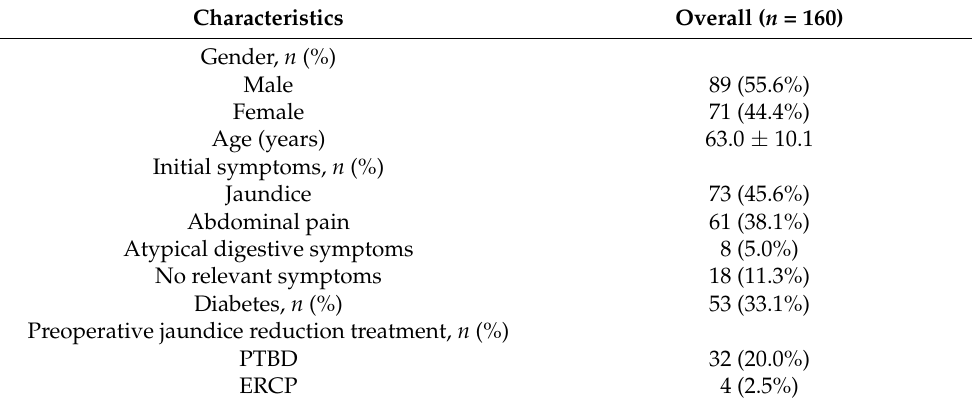
Table 1. Characteristics of the 160 pancreatic cancer patients.